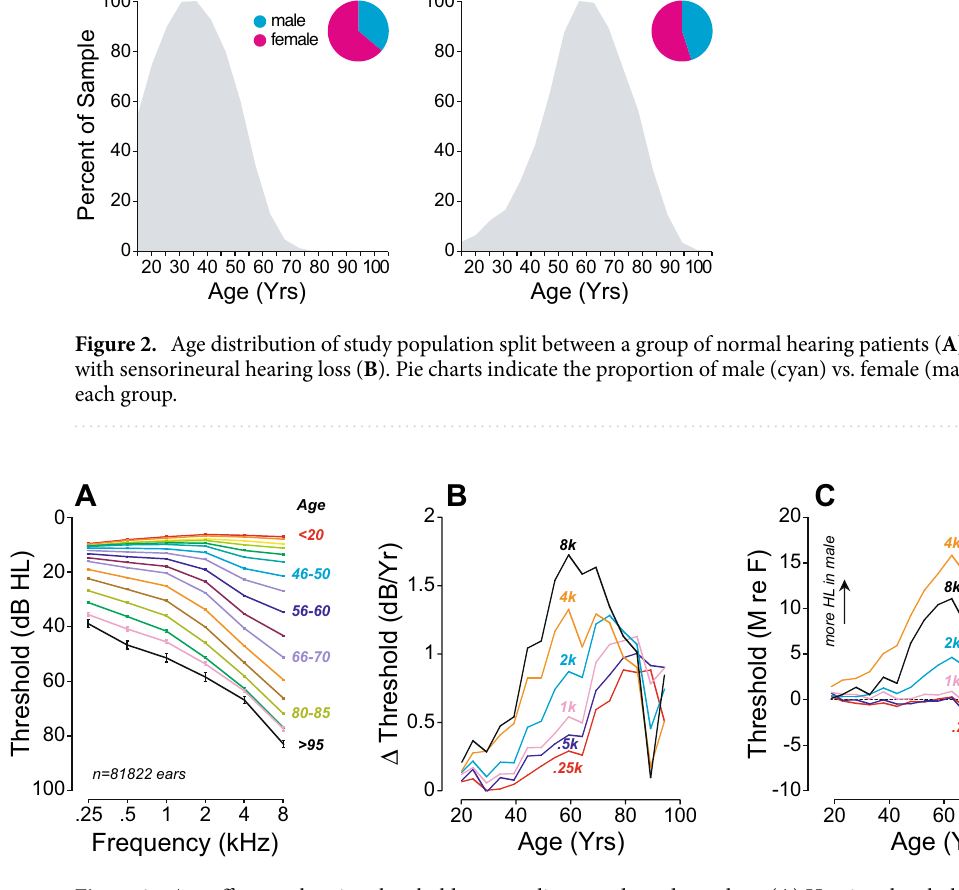
Figure 3. Age effects on hearing thresholds are nonlinear and sex dependent. ( A ) Hearing thresholds at standard audiometric frequencies in study population. ( B ) Progression of hearing loss as a function of age and test frequency. ( C ) Effect of sex on audiometric thresholds as a function of age. Error bars are standard error of